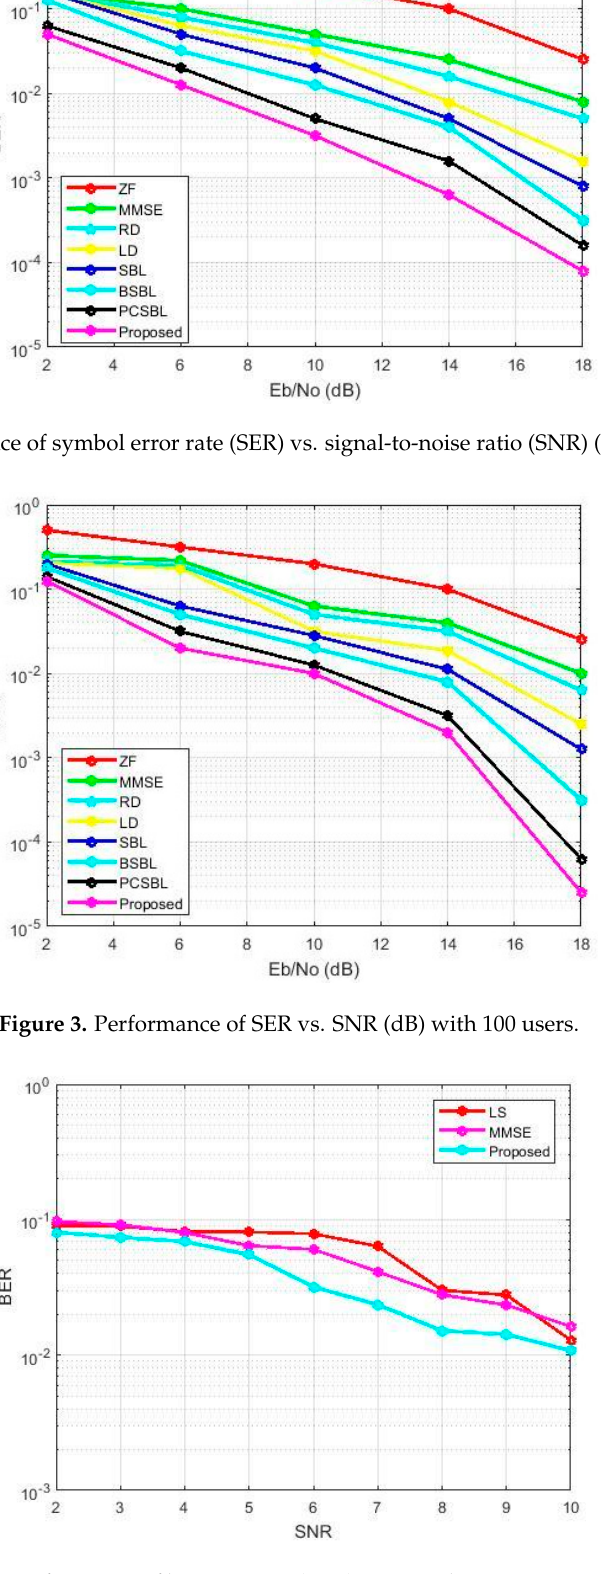
Figure 4. Performance of bit error rate (BER) vs. signal-to-noise ratio (SNR).